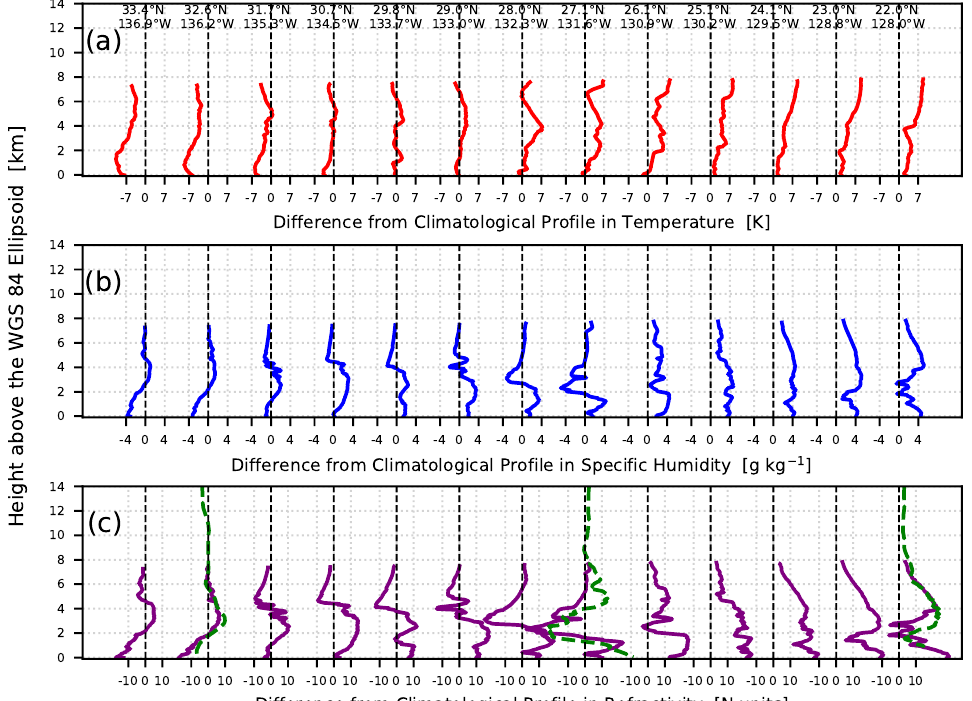
Figure 19. Vertical profiles derived from the easternmost dropsonde transect through the atmospheric river shown in Figure 18. The dropsonde profiles are arranged starting with the northwestern-most on the left and southeastern-most on the right, and the difference in ( a ) temperature (red lines), ( b ) derived specific humidity (blue lines), and ( c ) derived refractivity (purple lines) with a zonal climatological profile at 27 ◦ N during February is shown for each dropsonde. The derived refractivity from a radio occultation paired to the given dropsonde is overlain (green dashed lines) on the derived refractivity from the dropsonde, when available. The locations of these pairs are indicated in Figure 18. The thick dashed black lines highlight the line of zero difference with the zonal climatology and the latitude and longitude of the release point of each dropsonde is